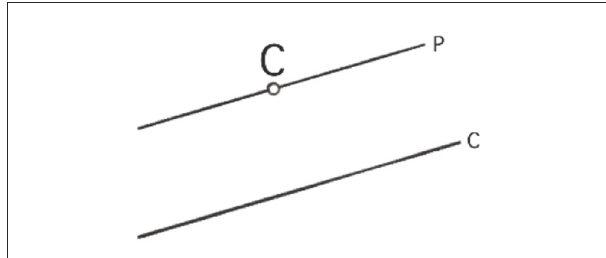
FIGURE4 Parallel postulate: There exists exactly one line p through C not lying on c.